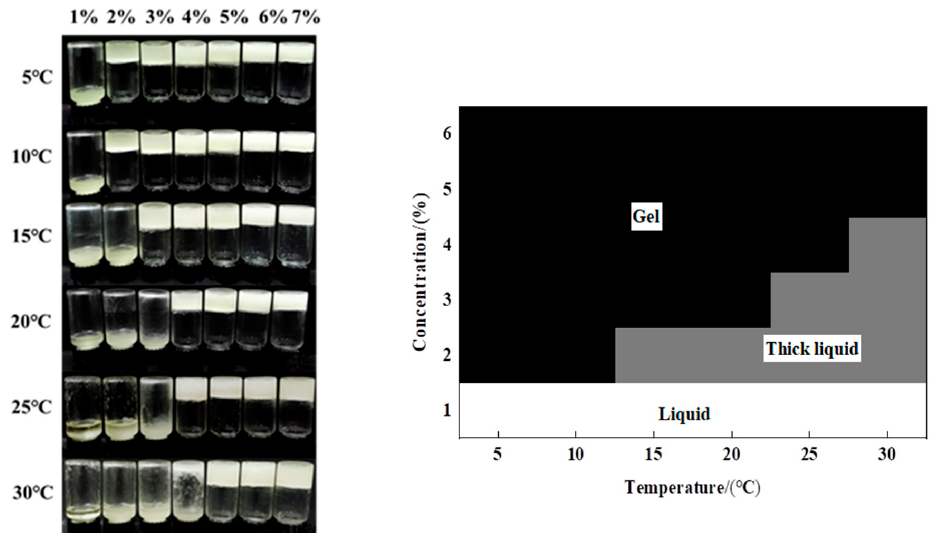
Figure 2. Temperature of Gelation Phase Diagram for different concentrations of stigmasterol organogels at different temperatures: gel (i.e., freestanding gel), thick liquid (liquid was clearly thickened, but freestanding gel was not observed), and liquid (i.e., no gelation observed).